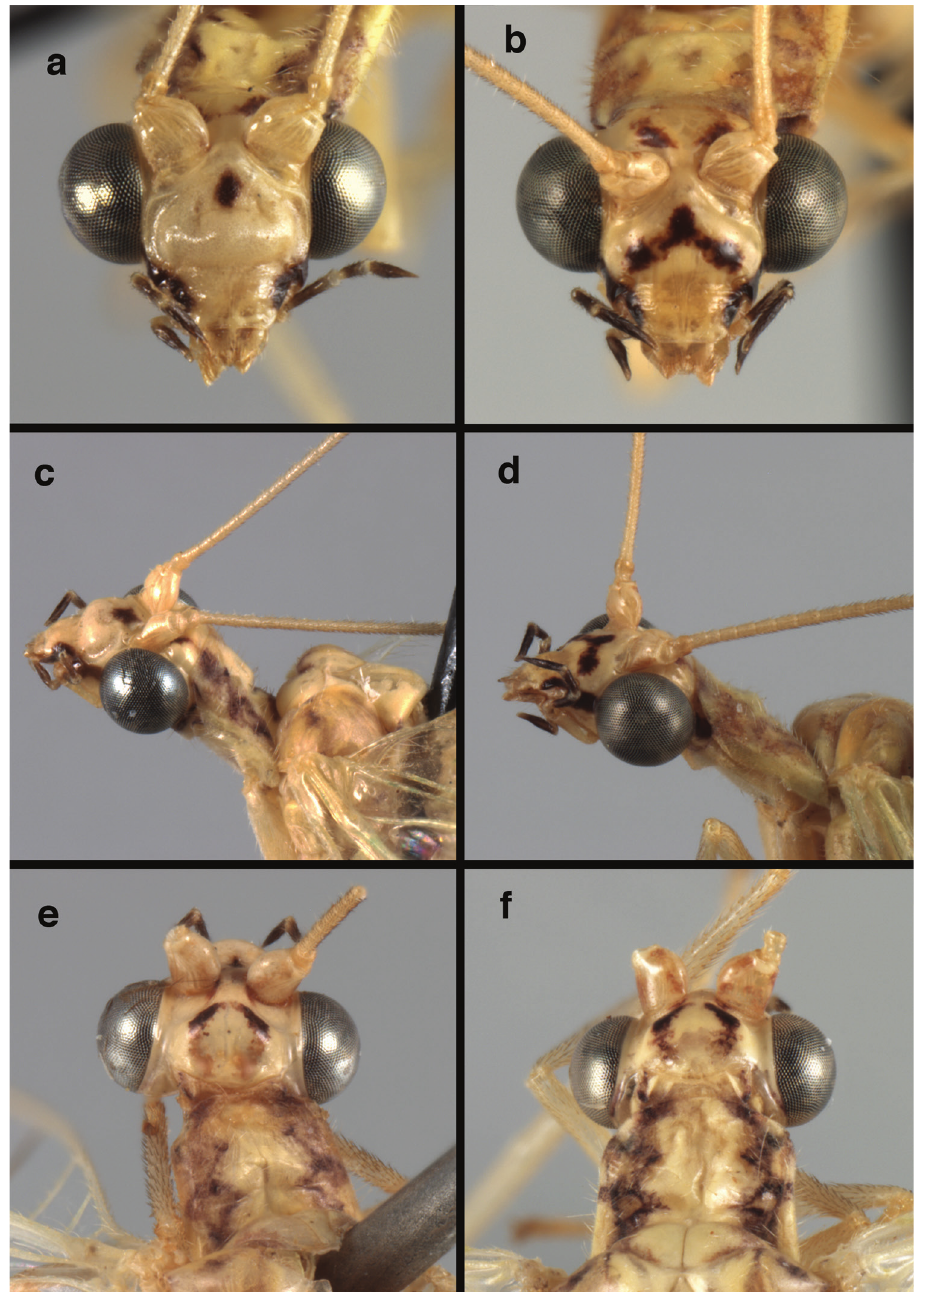
Figure 4. Ungla adamsi Tauber, sp. n.: Sexual dimorphism; male on left, female on right, ( a, b ) head, frontal ( c, d ) head, prothorax, lateral ( e, f ) head, prothorax, dorsal. Note: male, frons inflated distally, mesal spot round; female, frons not inflated, marking extended laterally (all: Peru, Machu Picchu; a, c holotype, FSCA; b, d paratype, FSCA; e paratype, BMNH; f paratype,